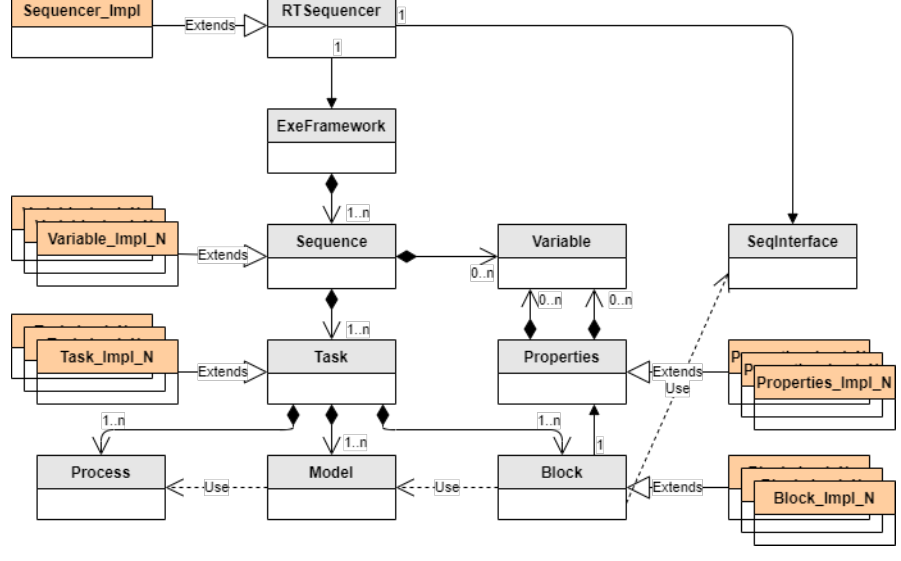
Figure 11. Execution